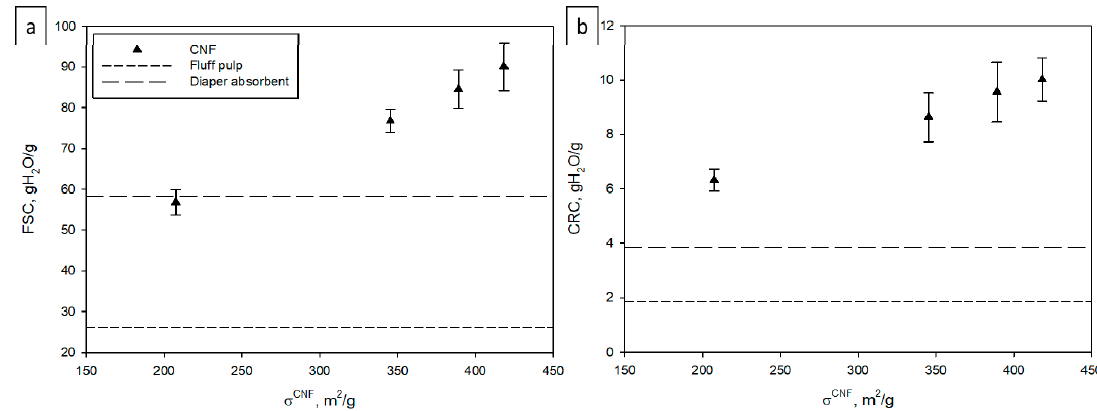
Figure 6. Effect of the specific surface on FSC at 60 min ( a ) and CRC ( b ) of CNF compared to fluff pulp and a commercial diaper absorbent.